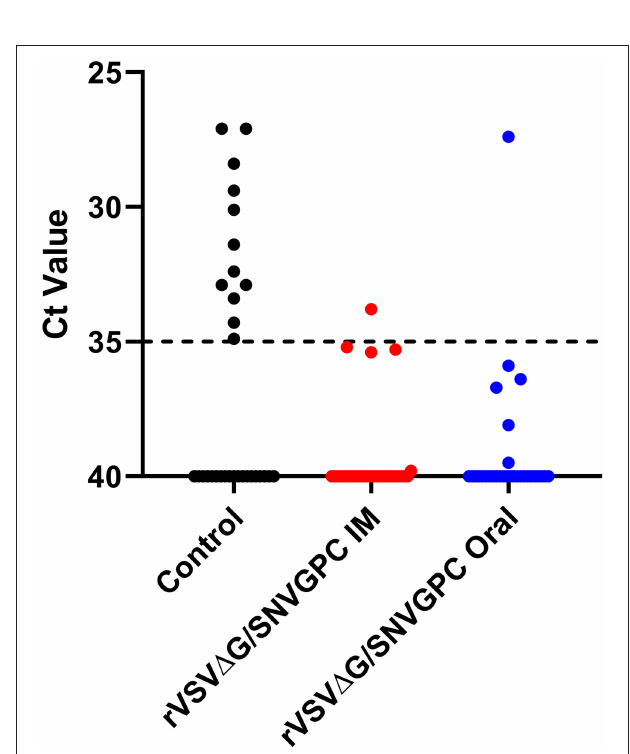
FIGURE 3 | SNV RNA levels in the lungs of transmission experiment deer mice. Following 6 weeks of exposure to SNV infected deer mice, vaccinated, or control deer mice were euthanized and the presence of SNV RNA was detected in the lungs. Shown are Ct values from the lungs of individual deer mice n = 30 for IM and oral groups, 31 for